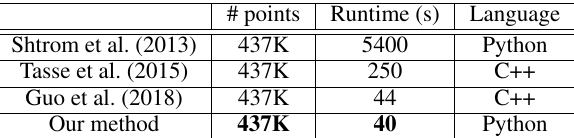
Table 1. Runtime comparison of the proposed